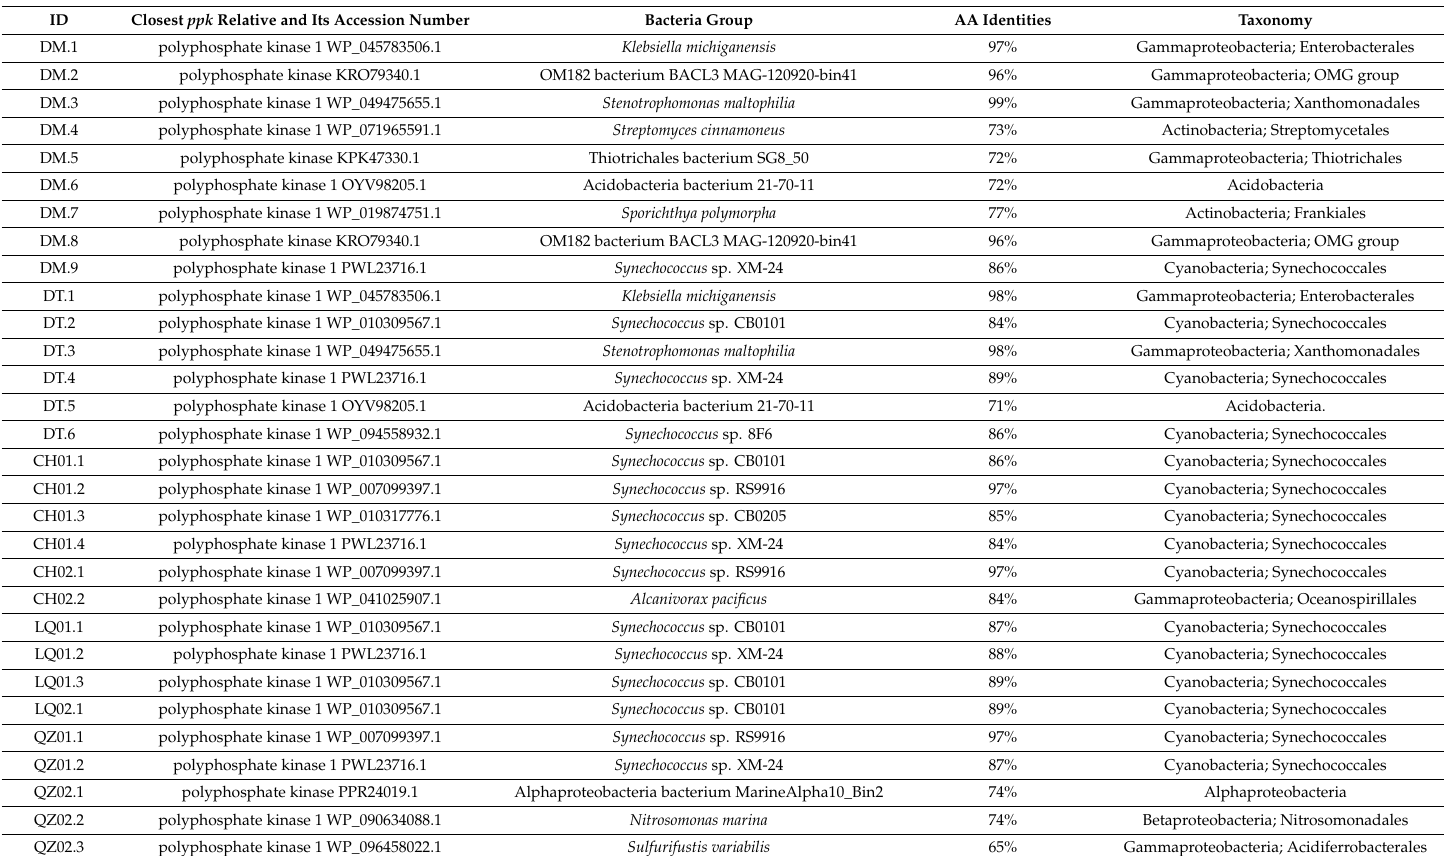
Table 2. The BLASTX results of ppk 1